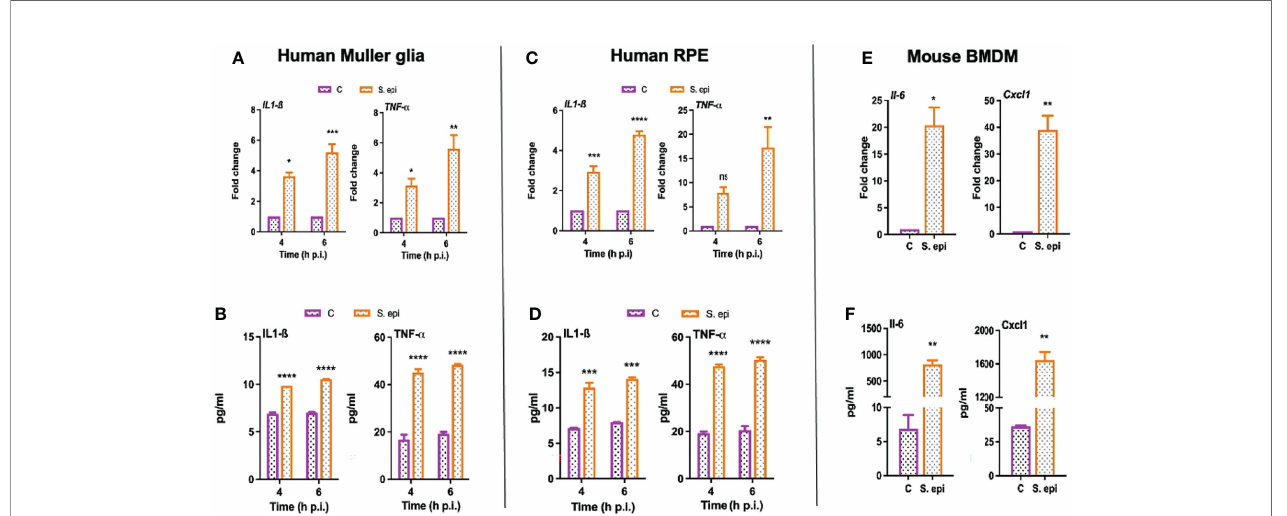
FIGURE 7 | S. epidermidis induces in fl ammatory responses in cultured mouse BMDMs and human retinal cells. (A, B) Human retinal Muller glial cells (MIO-M1 cell line) (C, D) human retinal pigment epithelial cells (ARPE-19 cells), and (E, F) mouse bone marrow-derived macrophages (BMDMs) were infected with S. epidermidis (MOI of 10) for 4 or 6 h. At indicated time points, cells were harvested for qPCR analysis of in fl ammatory cytokines/chemokines (A, C, E) , and culture supernatants were used for ELISA to quantify their protein levels (B, D, F) . Statistical analysis was performed using ANOVA with Sidak ’ s multiple comparison test (A – D) and t-test